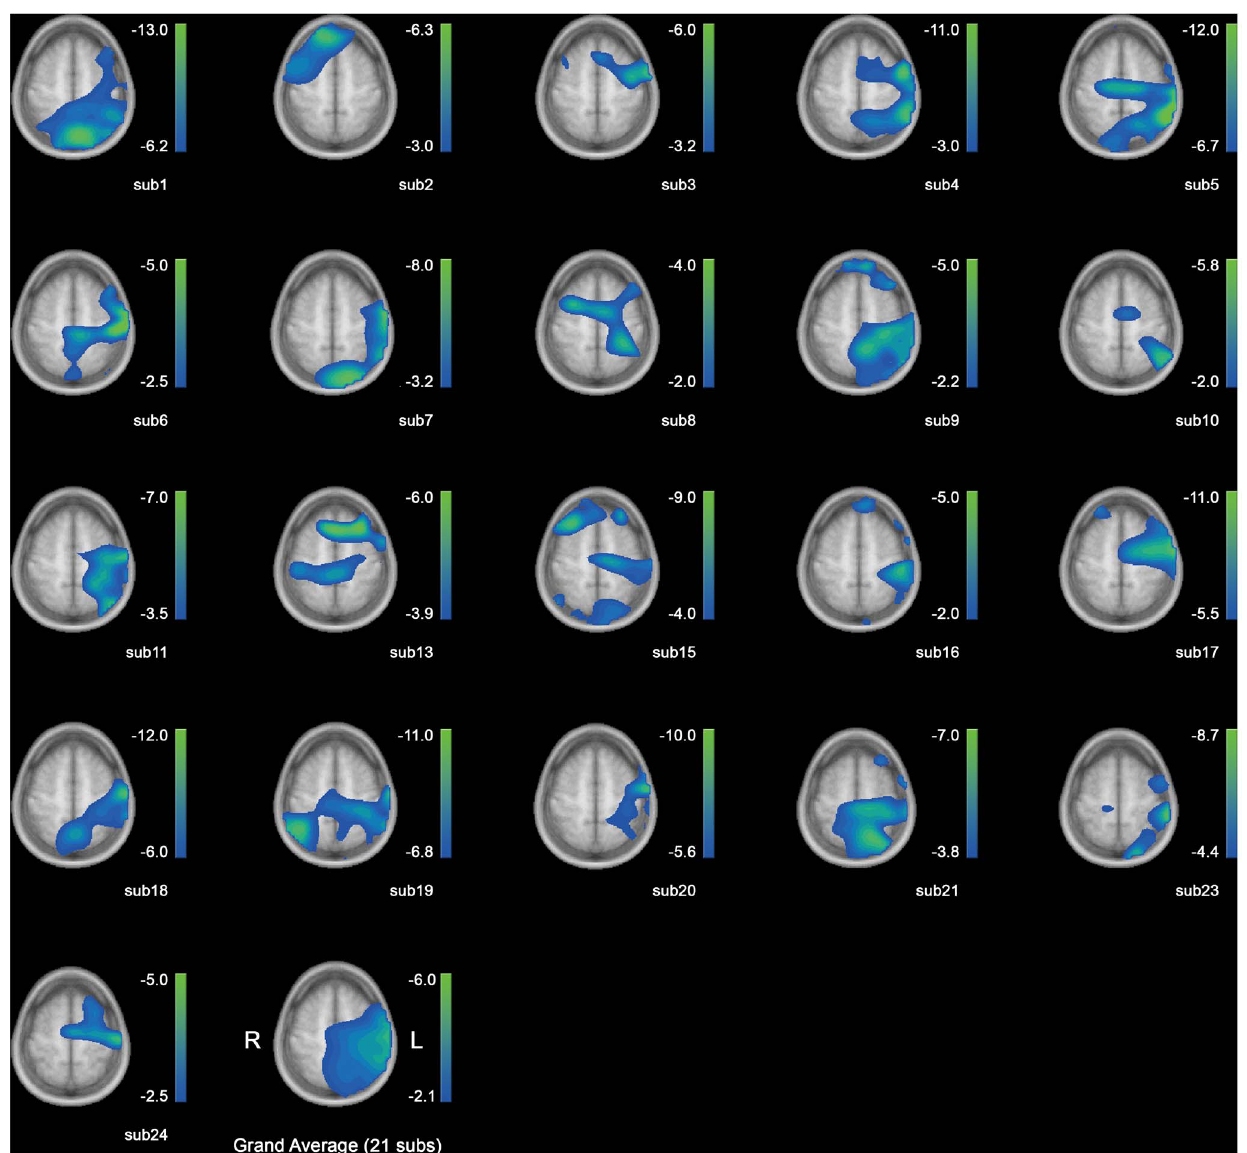
Figure 5. Source reconstruction for beta-ERD for 21 subjects. From the upper left to right; subject 1 , 5, in ascending order down to subject 24 in the bottom line, excluding subjects 12, 14 and 22. Grand average is on the last grid. The numbers in the scale bars indicate the amount of activity change from baseline in percent. Left is right and right is left.